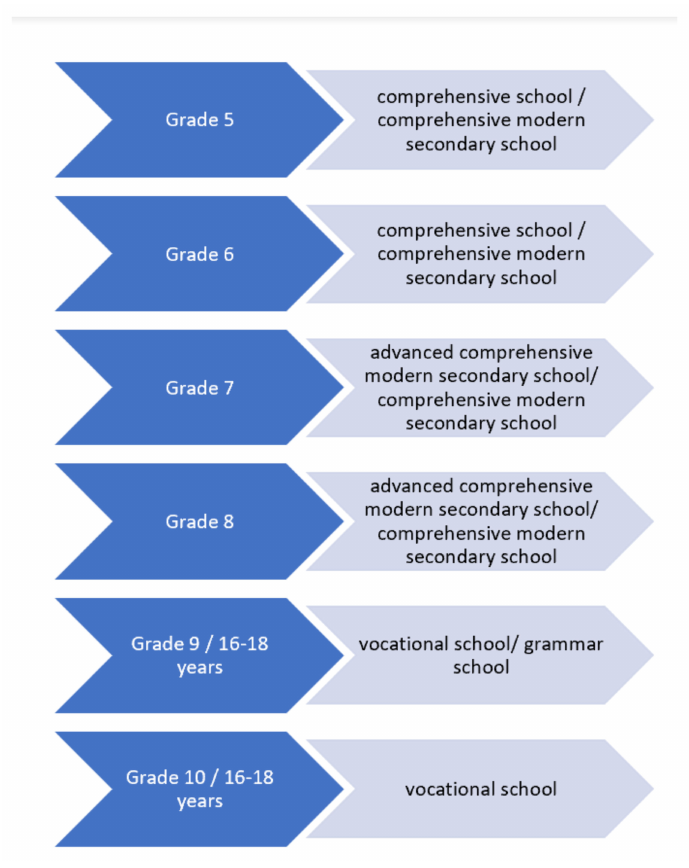
Figure 4. Guideline of the school inspectorate for the assignment of newly arrived refugee children in North